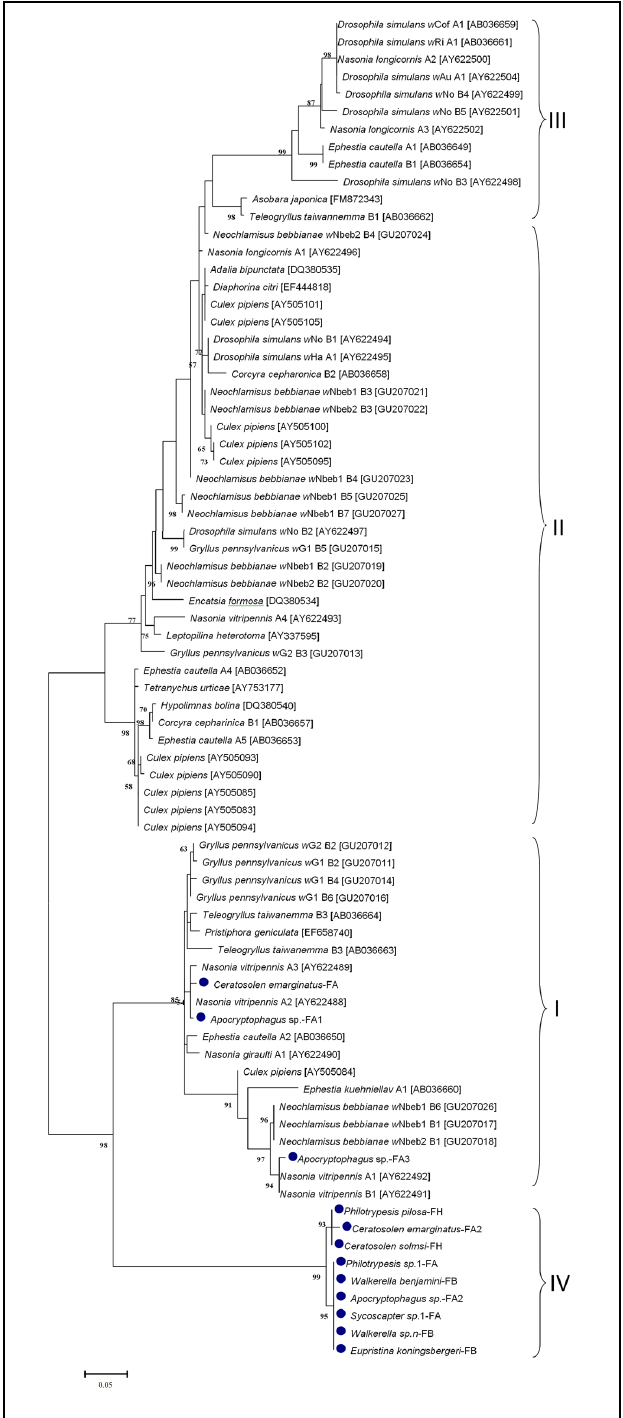
FIGURE 2 | Maximum likelihood phylogenetic tree of the bacteriophage orf7 nucleotide sequences. The sequences of fig wasps tested in our survey are marked with • . Some related sequences were downloaded from GenBank, and the accession IDs of the downloaded sequences are annotated with brackets. Different groups are indicated with I, II, III, IV. Samples tested in our survey are named by insect host name followed by the fig name (FA: Ficus auriculata, FH: Ficus hispida , FB: Ficus benjamina ) and haplotype